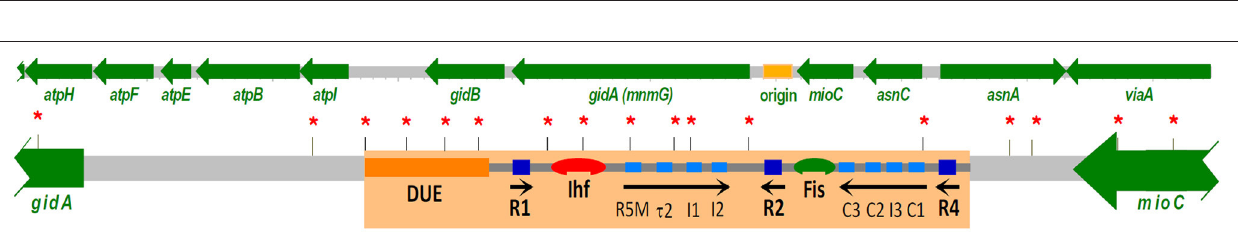
from a decreased initiation mass (Churchward et al., 1983).